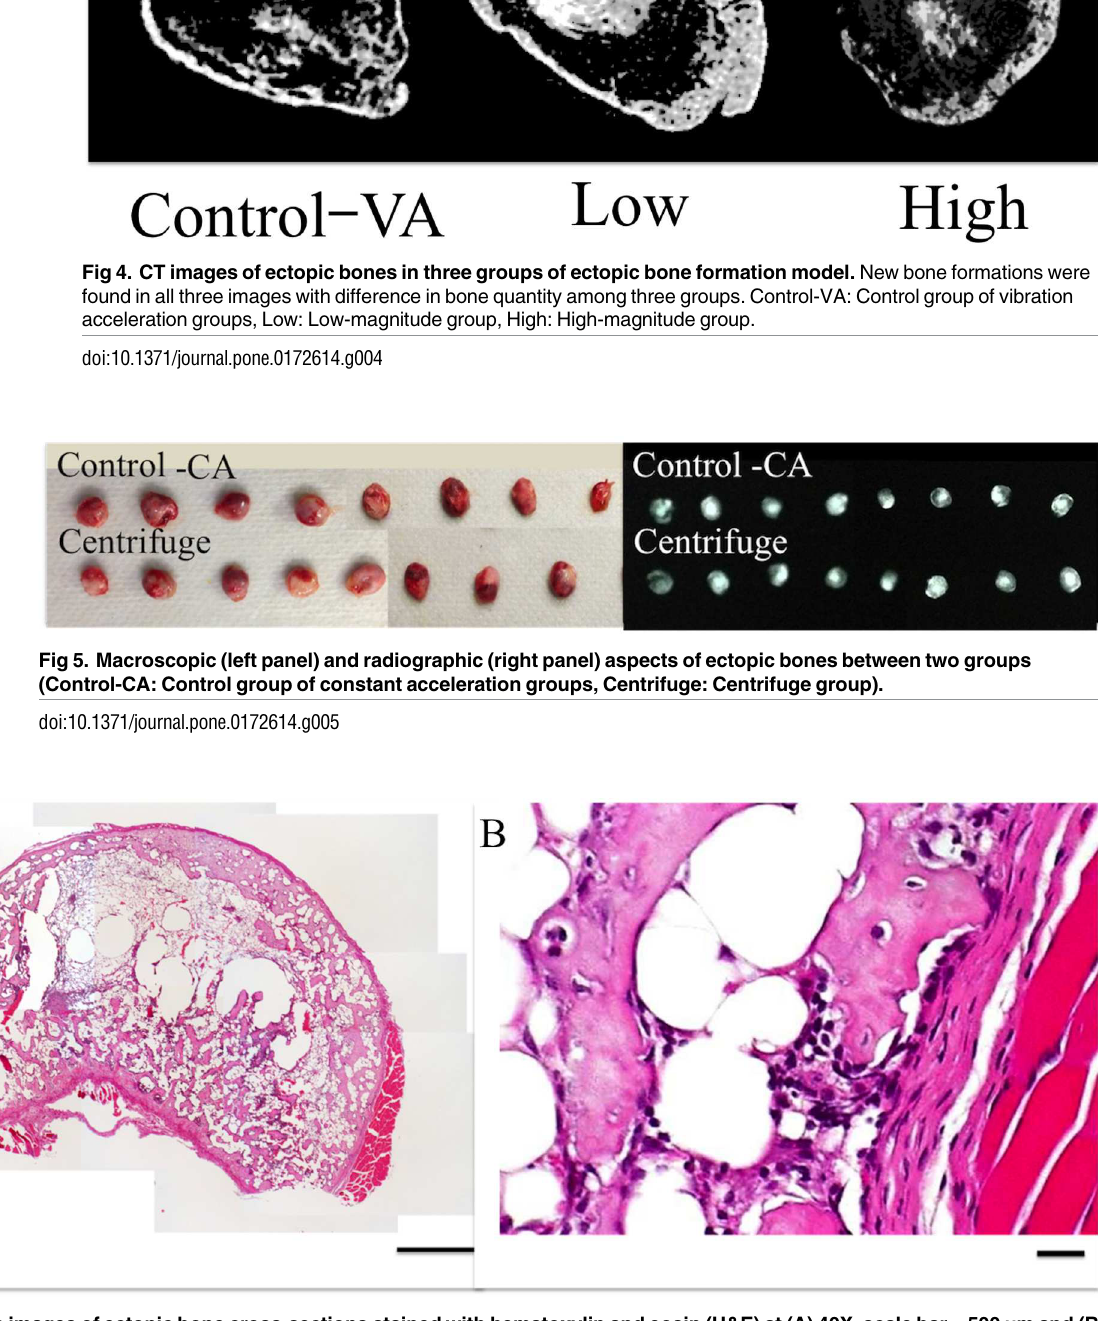
Fig 6. Microscopic images of ectopic bone cross-sections stained with hematoxylin and eosin (H&E) at (A) 40X, scale bar = 500 μ m and (B) 400X, scale bar = 100 μ